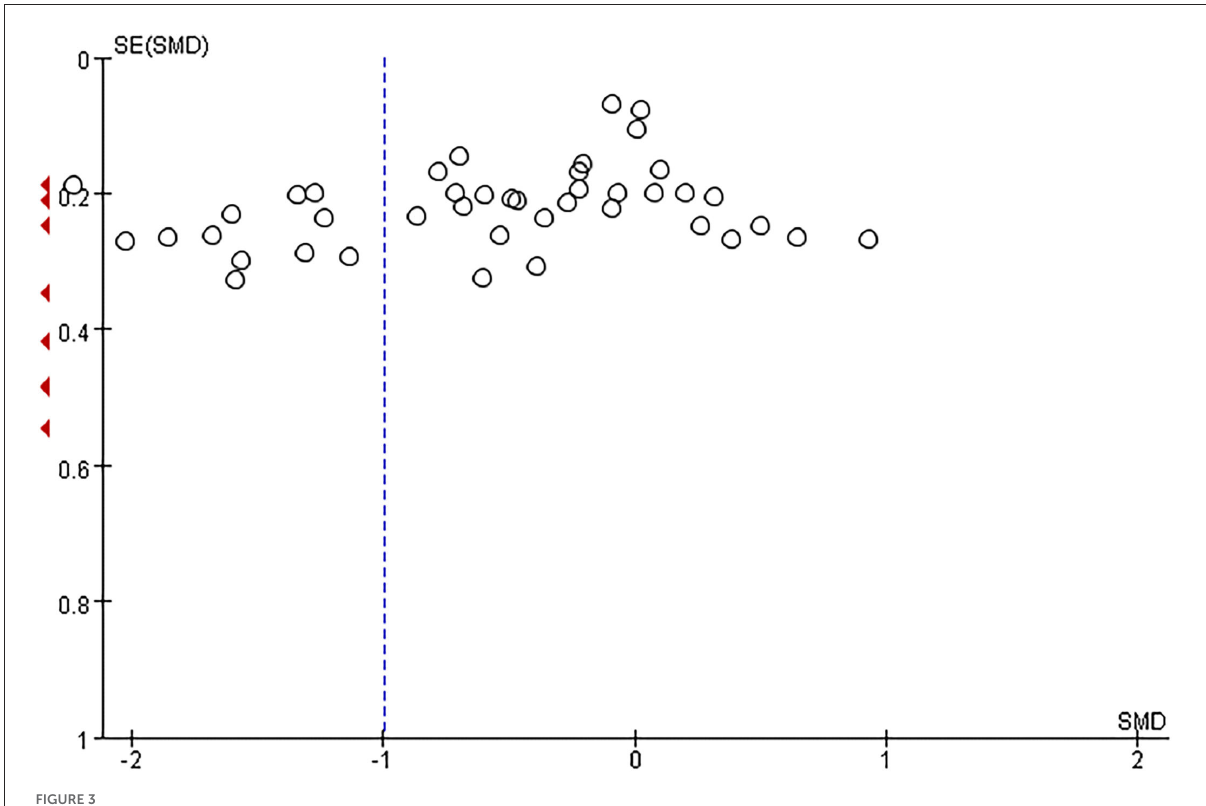
FIGURE3 The funnel plot to assess publication